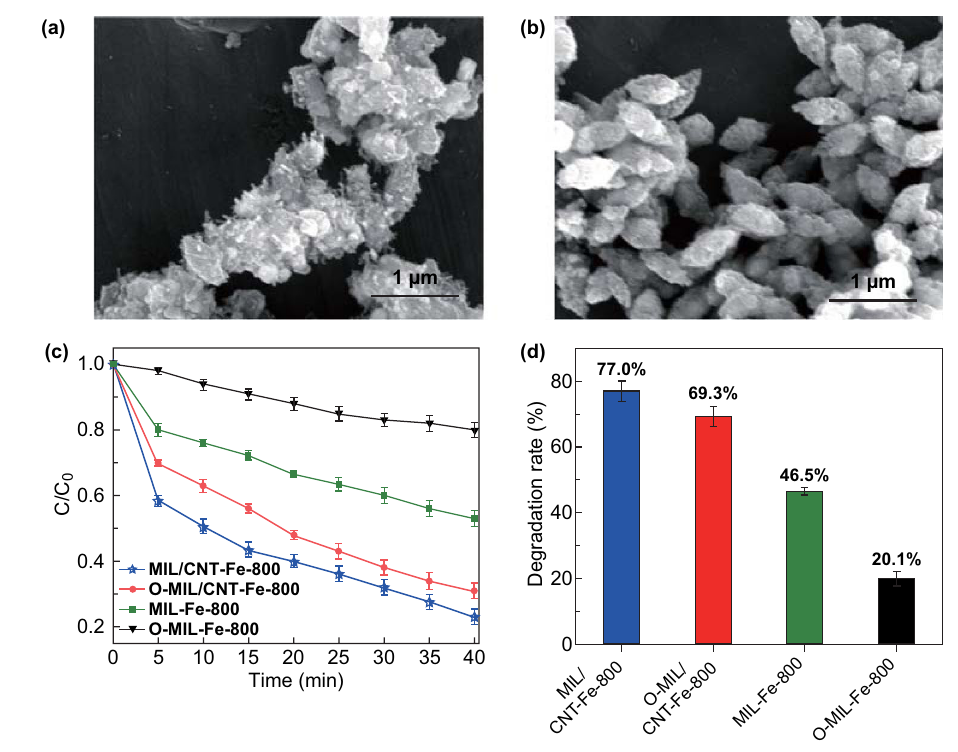
Fig. 6 a SEM image of O-MIL/CNT–Fe-800. b SEM image of O-MIL-Fe-800. c Contrast experiment of iron oxide for BPA degradation. d Degradation rate (%) of BPA with different catalysts in 40